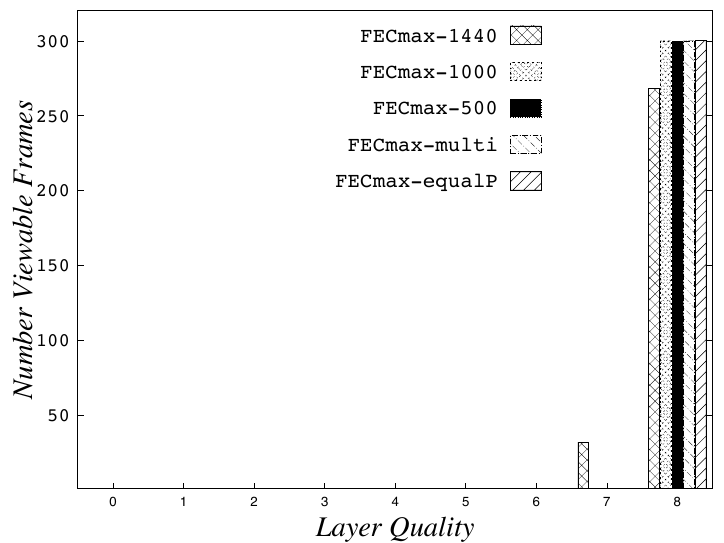
Figure A24. Example of the number of viewable layers for SVC-SC, for each of the FEC max Packet thres , at a packet loss rate of 10% and a GOP of 32. This image illustrates an increase in the FEC max for C1 and C2 based on the worst case scenario, as shown in Table A2.